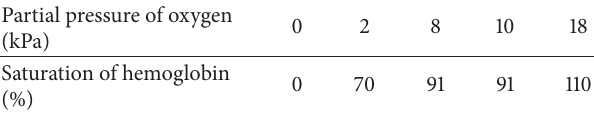
Table 2: The varying ability of myoglobin.